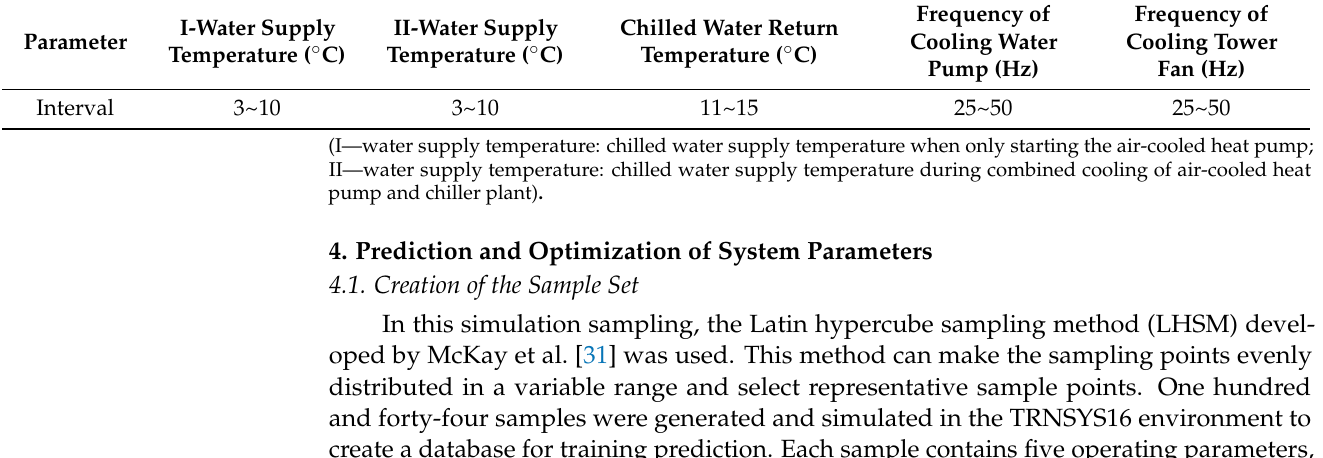
Table 3. The range of optimization parameters of the refrigeration